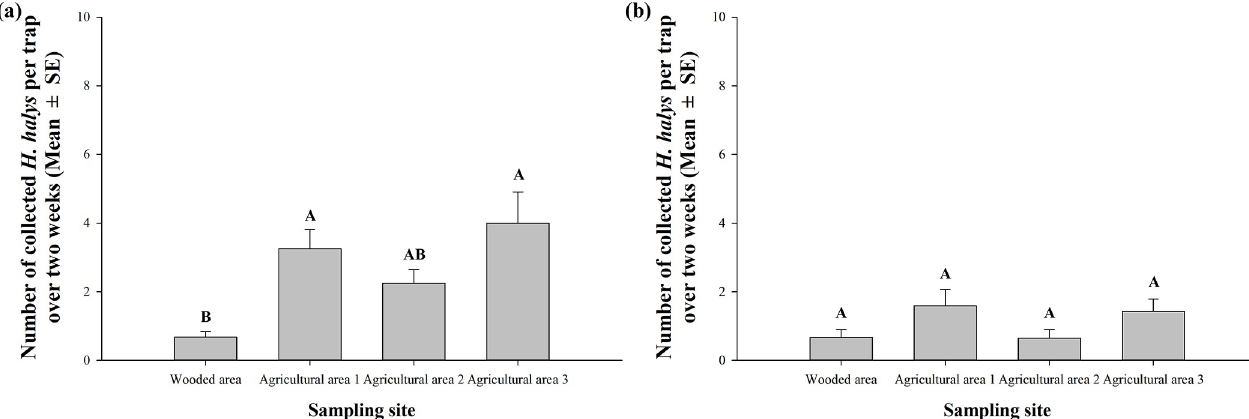
Fig 3. The number of Halyomorpha halys collected over two weeks per pheromone trap in early October through late November in Ulsan region (a) and mid- October through early December in Pyeongtaek region (b). Note that low dose of pheromone lures was used in wooded area (see Materials and Methods). Different letters indicate significant difference among sampling sites ( p <